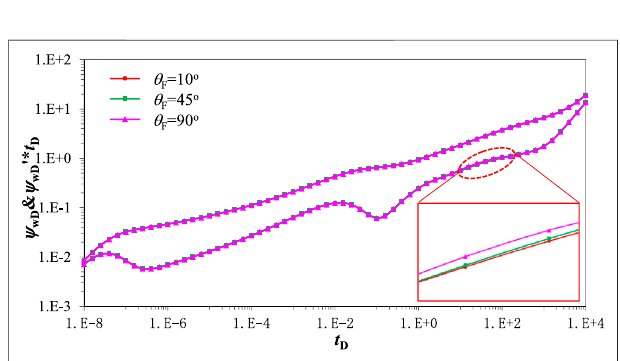
FIGURE13| Ratedistribution curveeffectedbystorativityratio.( C D =1e- 5, S =0.01, x asymD =0.3, L F =150 m, θ F =90 o , C FD =10, R e = 3000 m, r o = 2000 m, λ = 1, σ = 0.7, β m = 3).